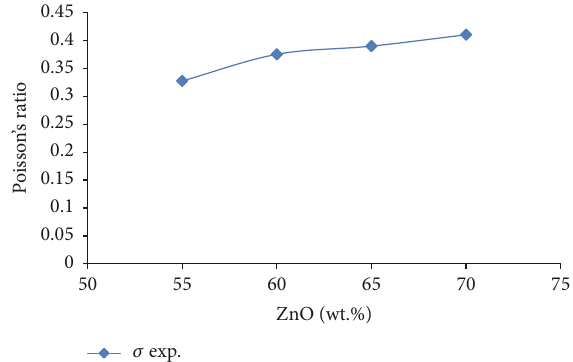
Figure 6: Bulk modulus versus wt.% of ZnO in ZnO–SiO 2 samples.